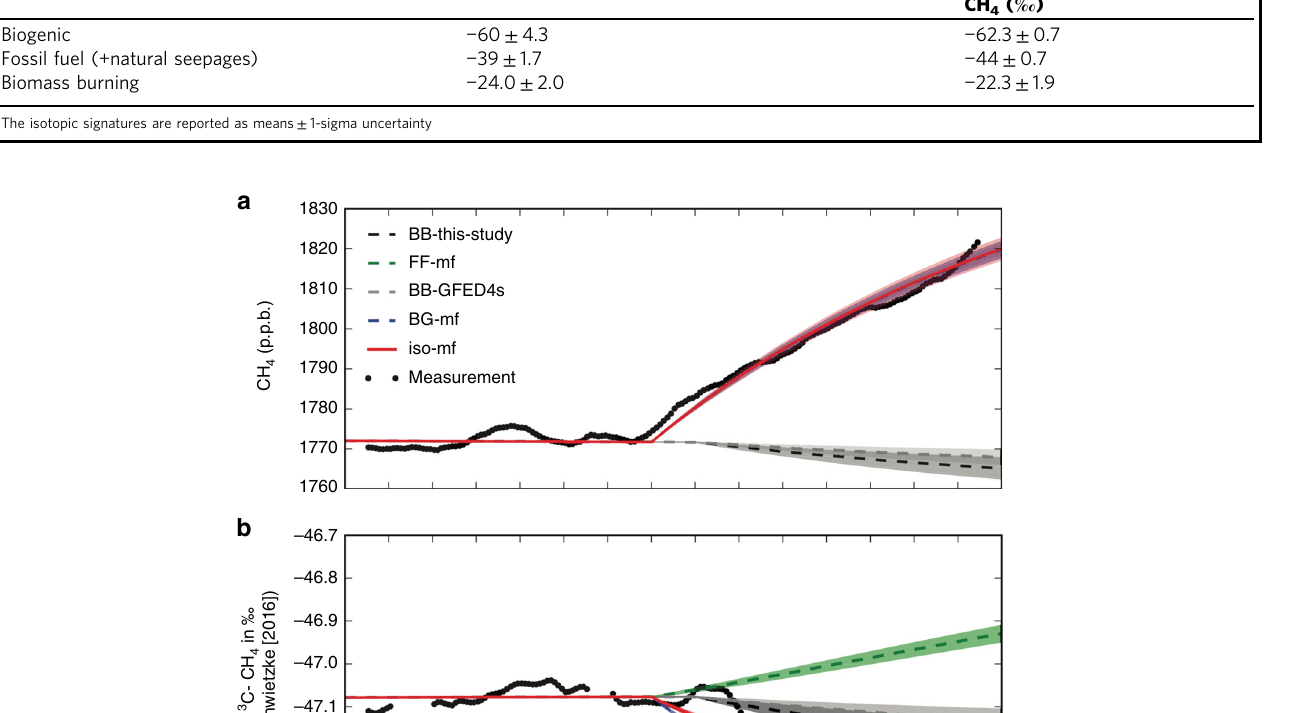
Table 1 Isotopic signatures of the three source categories used in our box-model analysis Source type